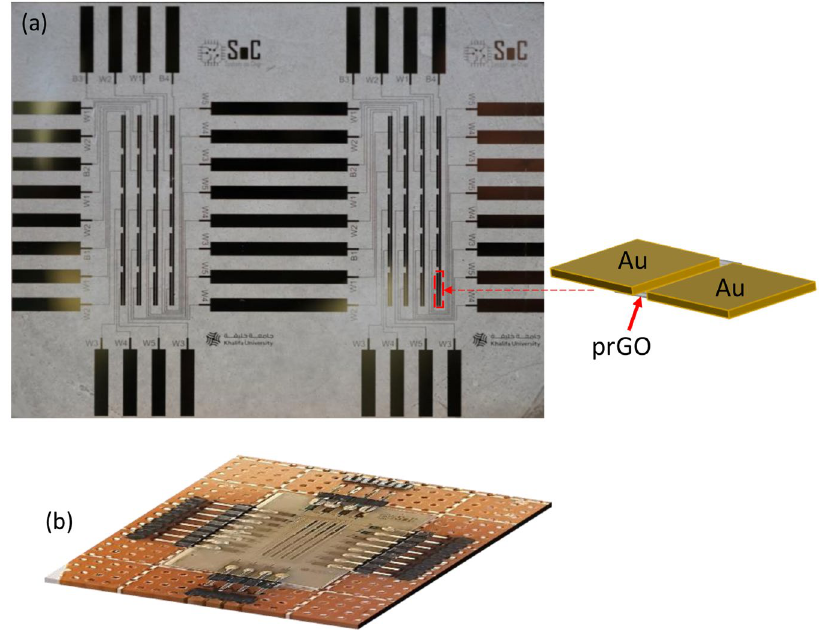
Figure 6. A macrograph of the fabricated NeuroMem-based ANN: ( a ) before, and ( b ) after cutting and conneting the crossbar to the electrical board. Figure inset shows the structure of one planar NeuroMem device pointed to one example location on the crossbar (Drawing Software: Microsoft Powerpoint